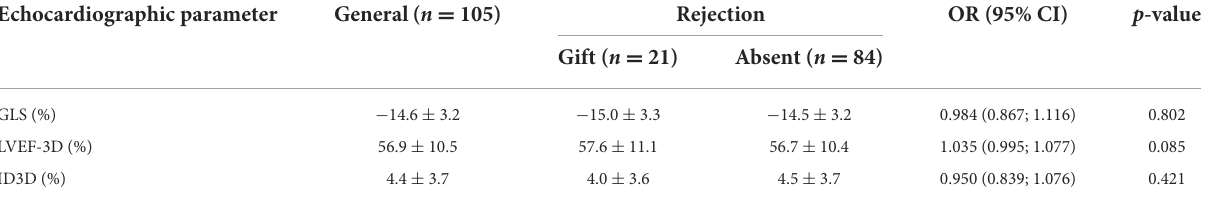
TABLE 6 Strain and three-dimensional assessment of the left ventricle according to rejection. Echocardiographic parameter